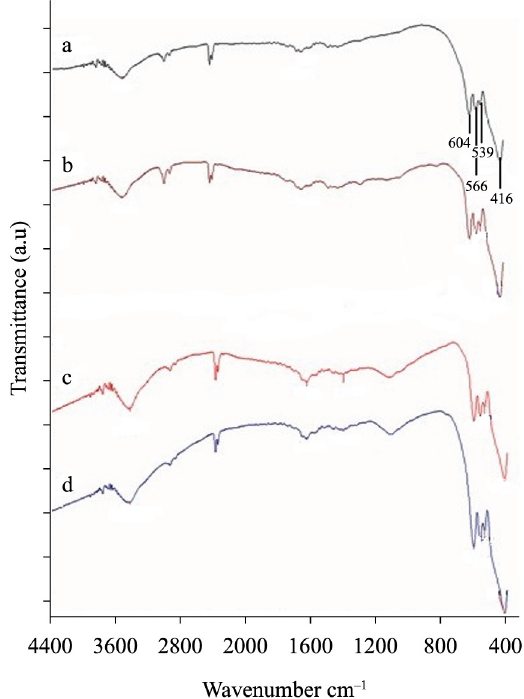
Figure 5. FT-IR spectra of In AcAc; b) γ-irradiated AcAc (10 2 kGy); c) Un-irradiated AcAc and SDS; d) γ-irradiated AcAc (10 2 kGy) and SDS.